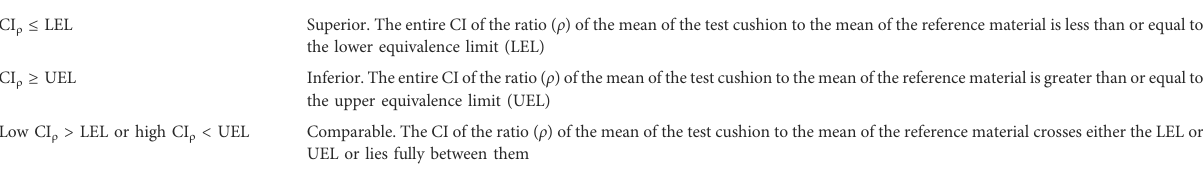
TABLE 2 Pressure magnitude classi fi cation de fi nitions.